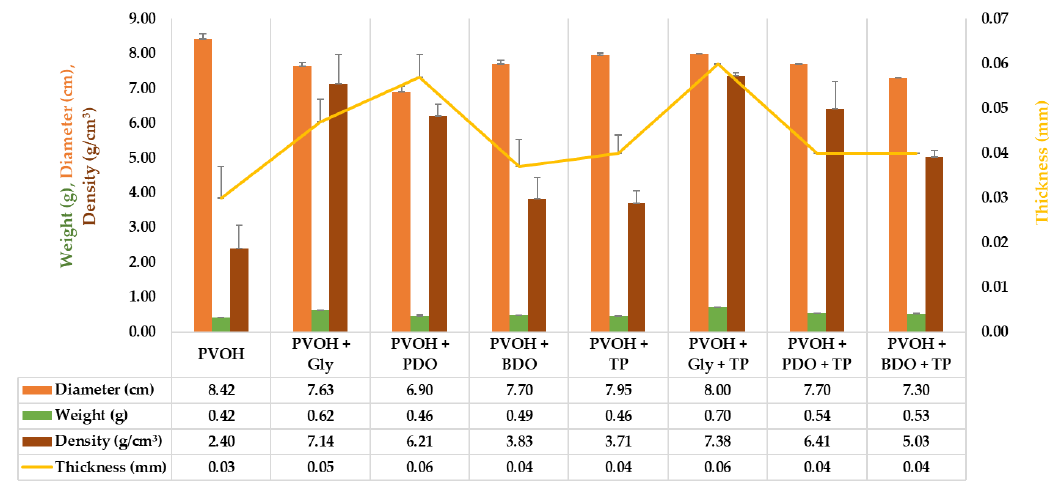
Figure 6. Physical measurements of solid biofilms based on PVOH. Reported data represents the average value of three replicates with their standard deviations